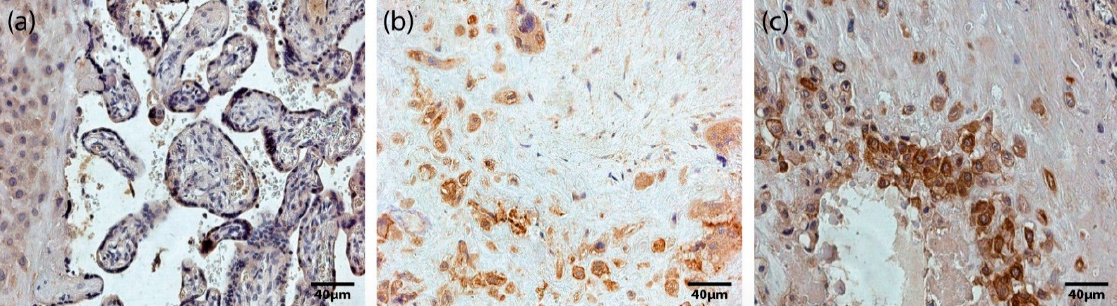
Figure 1. HoxB3-containing structures of the placenta. ( a ) Maternal part and tertiary villi of a 31 gestational week placenta with numerous (+++) HoxB3-containing cells of extravillous trophoblast, cytotrophoblast and syncytiotrophoblast (HoxB3 IMH, X 250). ( b ) Maternal part of a 32 gestational week placenta with numerous (+++) HoxB3-containing Höfbauer cells (HoxB3 IMH, X 250). ( c ) Maternal part of a 40 gestational week placenta with numerous (+++) HoxB3-containing extravillous trophoblast and Höfbauer cells (HoxB3 IMH, X 250).